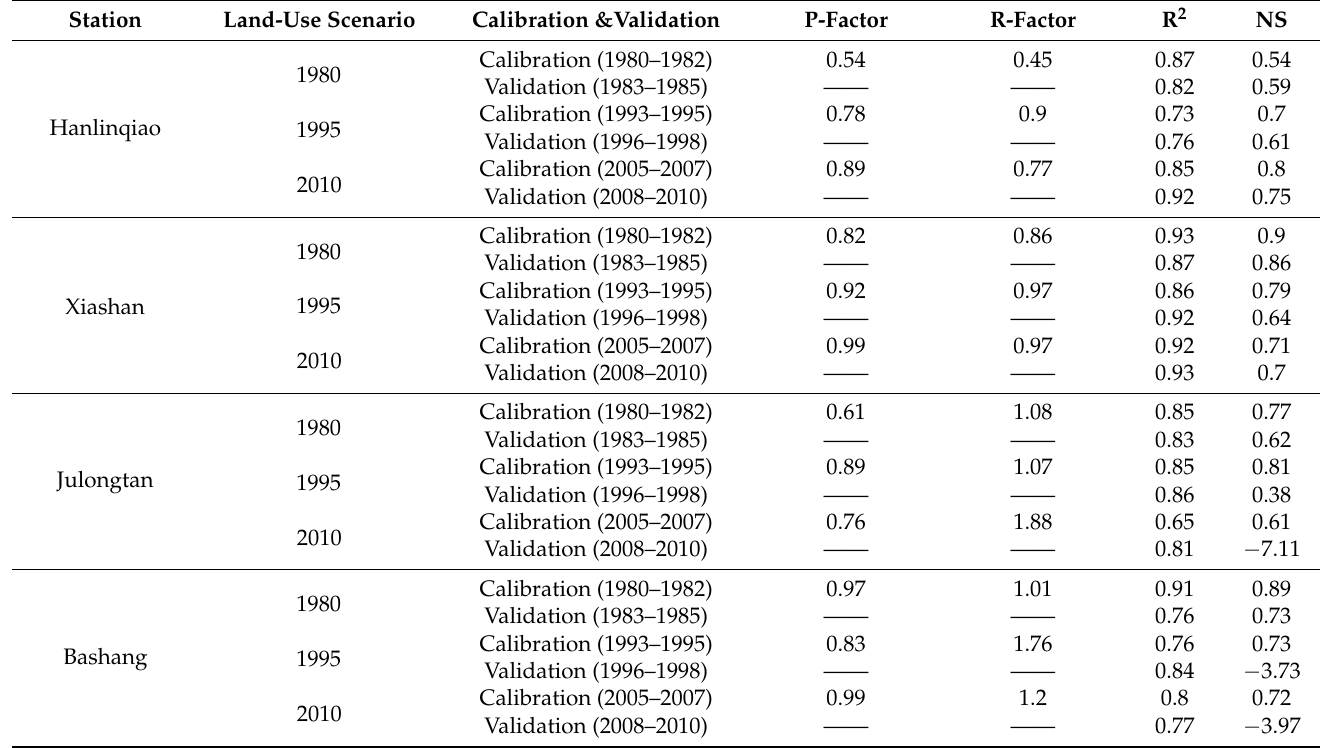
Table 2. Results of uncertainty analyses and evaluations of the sediment simulations under three historical scenarios—1980, 1995, and 2010—at each hydrological station.